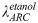
PhPP of S. stipitis showing λARCetanol.(a): Reactions eliminated. (b): Reactions inhibited by 80%. (c) Shows PhPP for specific ethanol production (qetoh) for reactions eliminated. (d) Shows PhPP for specific ethanol production (qetoh) for 80% inhibition.